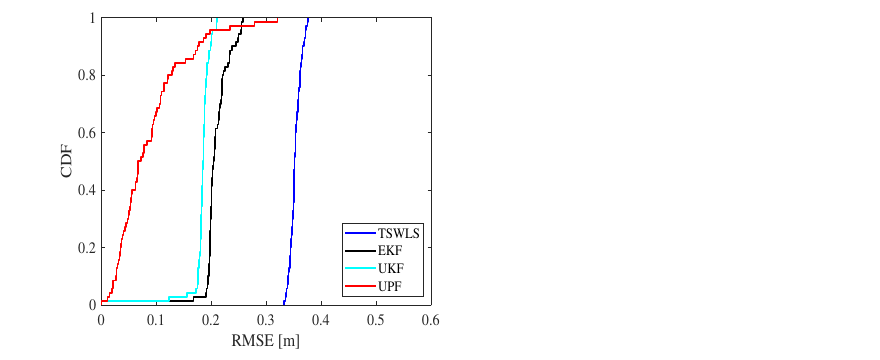
Figure 12. The CDF of RMSE for different algorithms in NLOS scenario ( σ θ